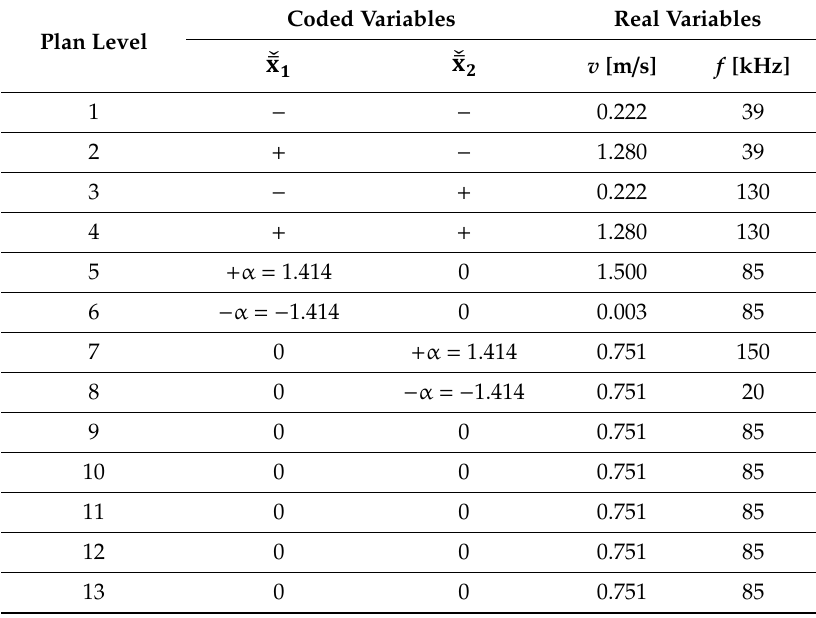
Figure 4. Test stand for cutting polypropylene foil using the phenomenon of cold ablation in various stages of operation: 1—frame made of aluminum profiles, 2—movable UV cutting head, 3—UV laser spot, 4—fixed table for laying polypropylene foil, unwound from a roll, 5—cut foil with dimensions 1040 mm × 1040 mm, 6—weights for pressing the foil against the table, 7—post for attaching the UV cutting head, moving along the X axis, 8—guide posts (7), 9—movable crossbar, 10—stationary upper right longitudinal member along the Y axis, 11—guides of the stationary upper right longitudinal member (10), 12—linear motor guide for driving along the X axis, 13—linear motor guide for driving along the Y axis, 14—chain guide for cables, 15—wires [34]. Table 3. Five-level rotatable plan of experiment.